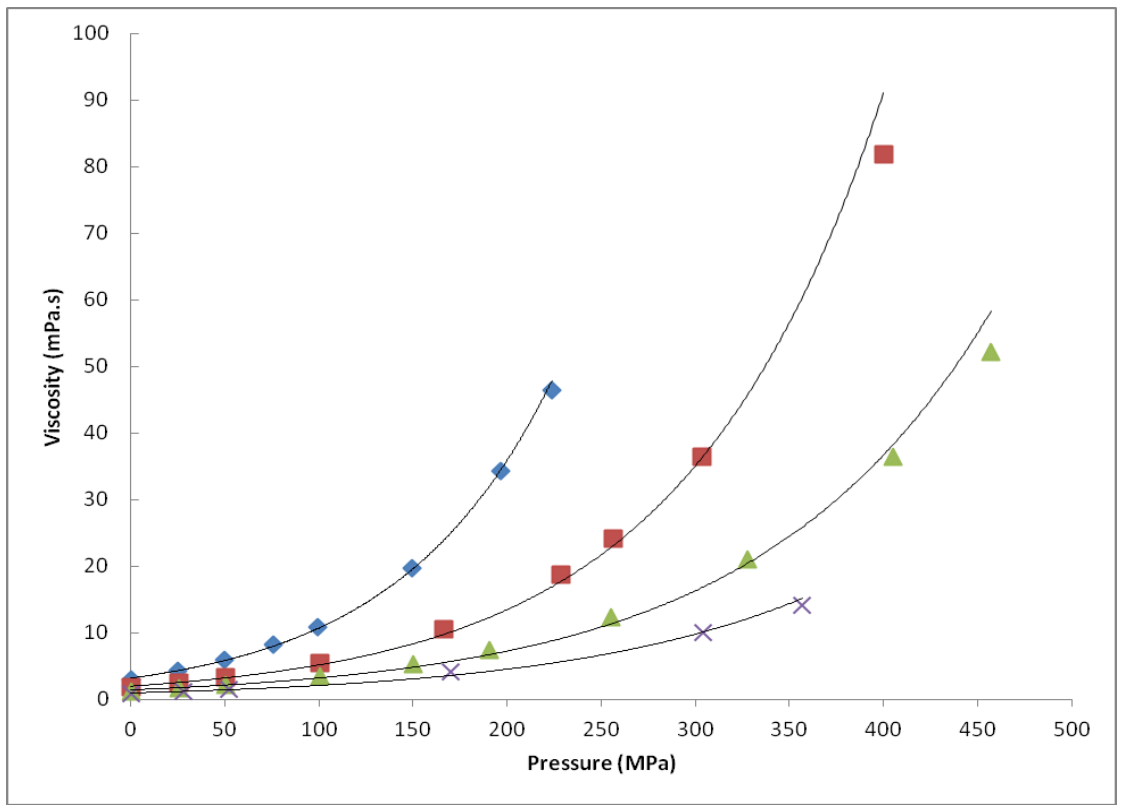
Figure 2. Variation of viscosity for Fuel 1 with temperature. ♦ 298 K, ■ 323 K, ▲ 348 K, and X 373 K.